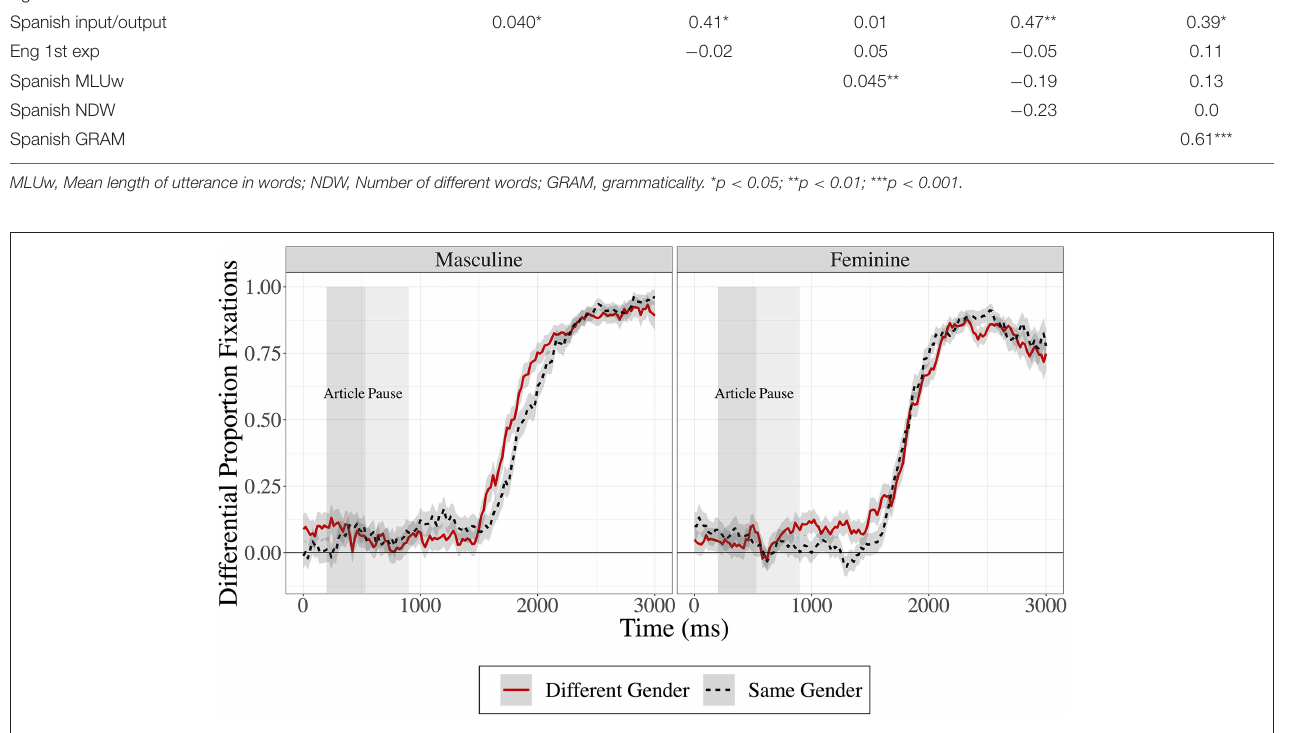
FIGURE 2 | Differential proportion fixations to target, with fixations in the different-gender condition in solid red lines and fixations in the same-gender condition in dashed black lines. Masculine targets are presented in the left panel and feminine targets are presented in the right panel. Time in milliseconds is presented on the x-axis and differential proportion of fixations to target is presented on the y-axis. The shaded regions represent ± 1 standard error of the